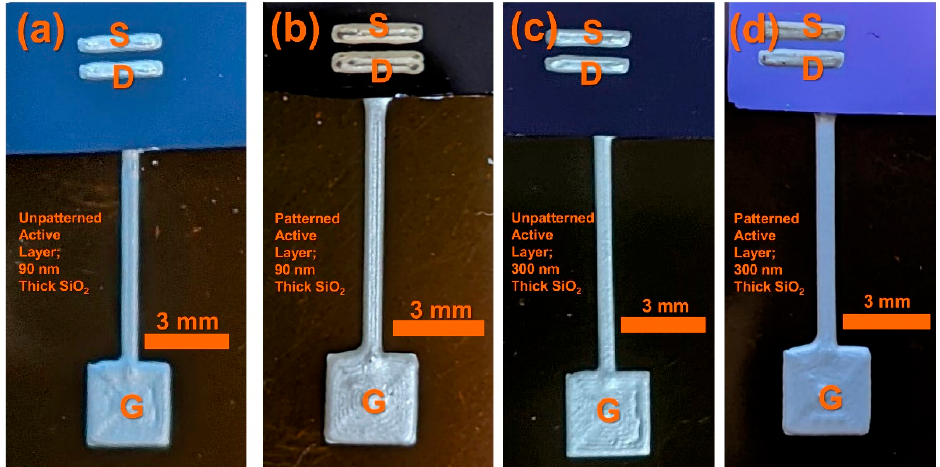
Figure 3. Top-down photographs of the ( a ) traditional (unpatterned) TFT with a 90 nm thick SiO 2 , ( b ) improved (patterned) TFT with a 90 nm thick SiO 2 , ( c ) traditional (unpatterned) TFT with a 300 nm thick SiO 2 , and ( d ) improved (patterned) TFT with a 300 nm thick SiO 2